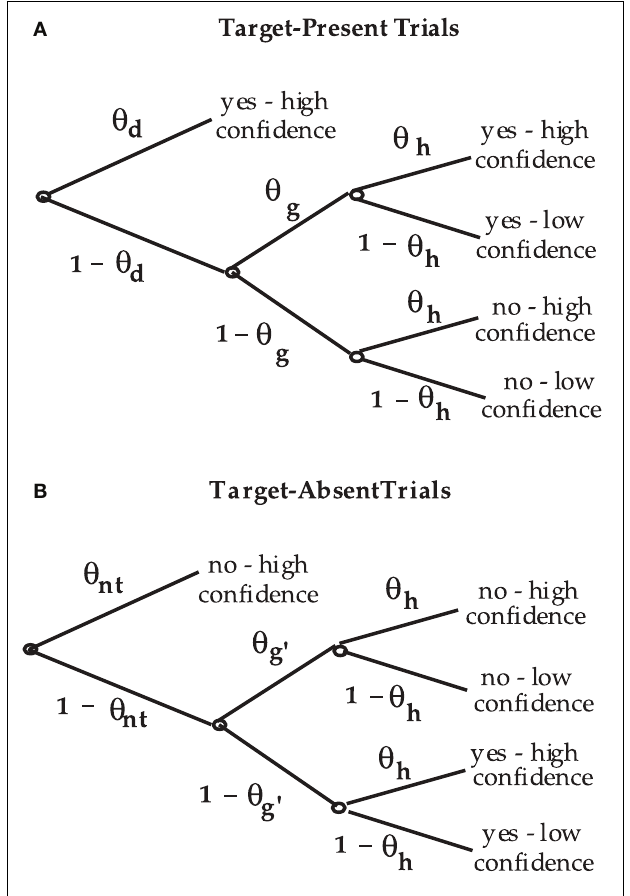
FIGURE 2 | Process tree for the PD model for (A) target-present test trials and (B) target-absent test trials.